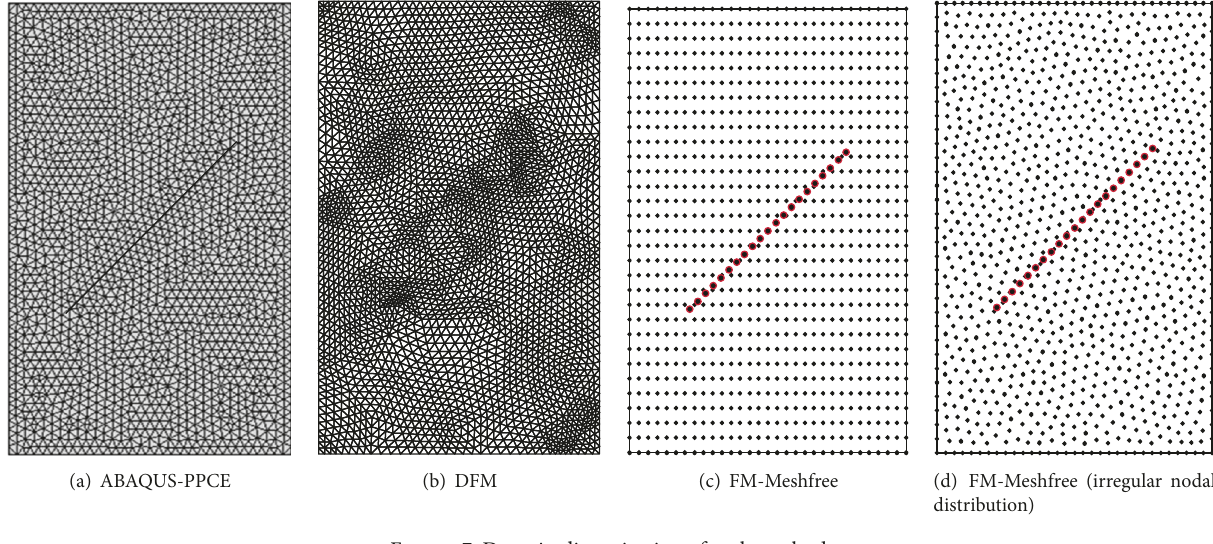
Figure 7: Domain discretization of each method.